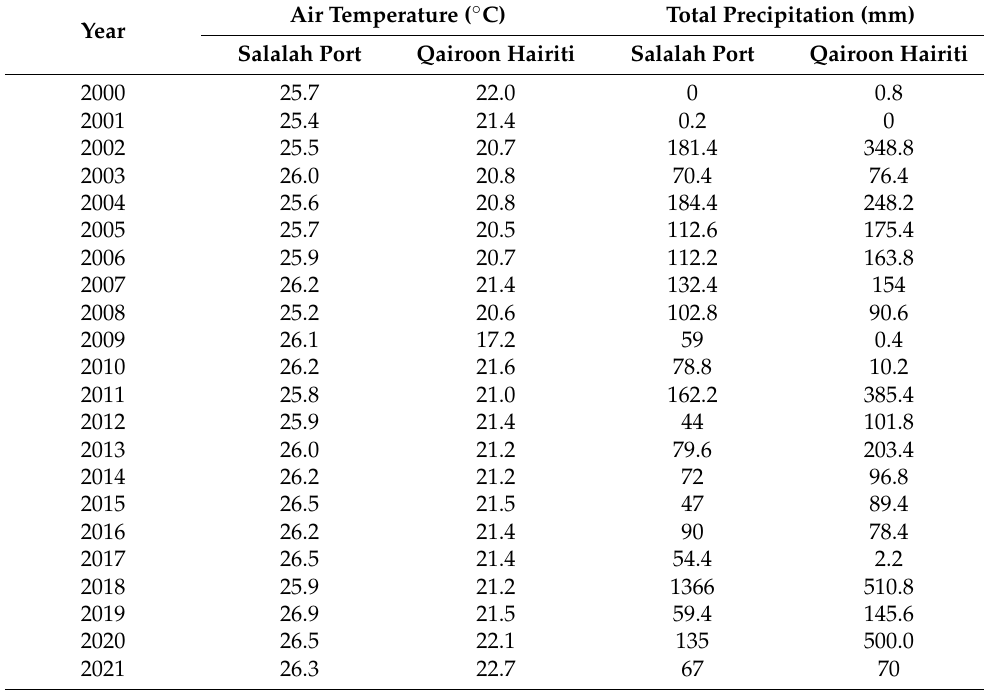
Table 2. Annual 2-metre air temperature and total rainfall over Salalah Port and Qairoon Hairiti station.